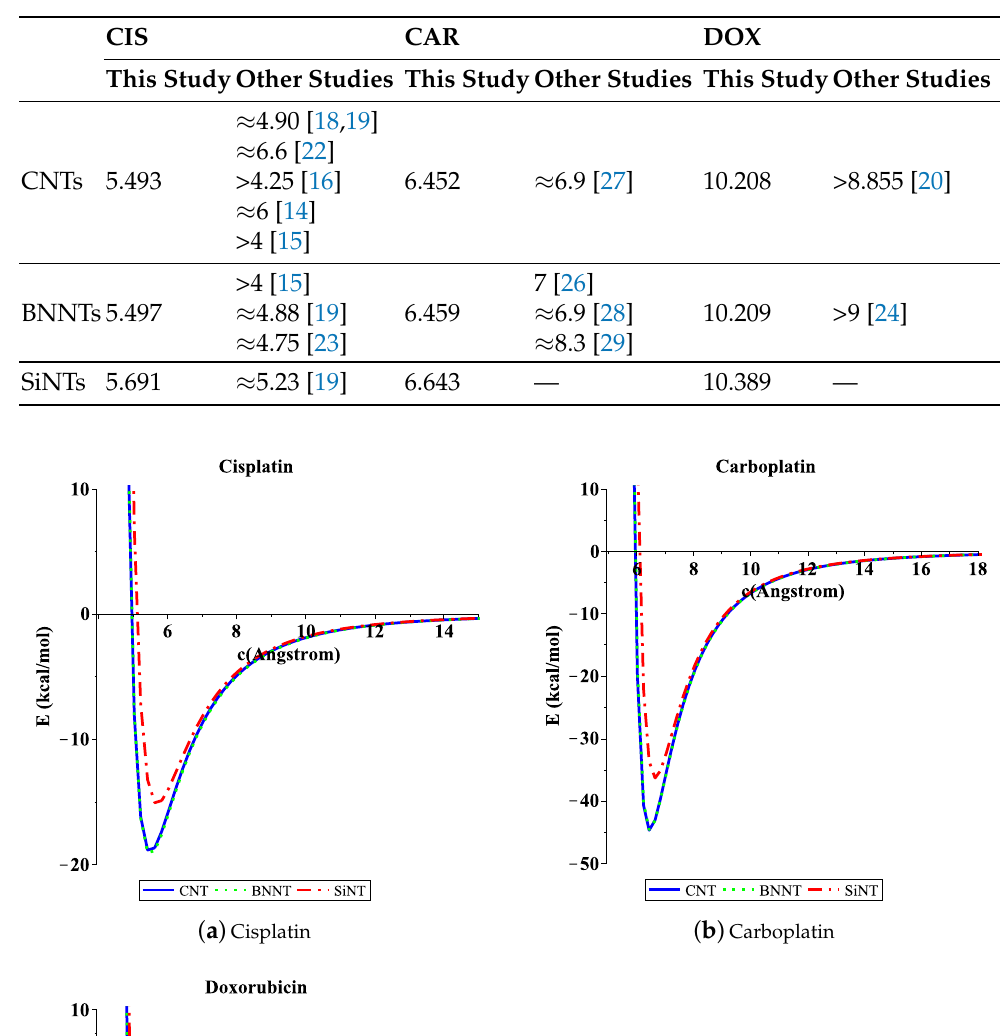
Table 4. Comparison of the values of radii (Å) in this study with those in other studies.